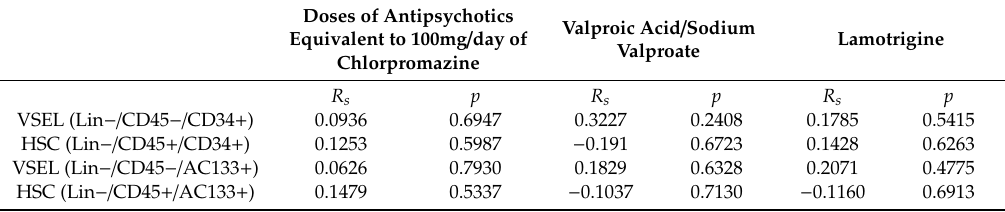
Table 3. Correlation between drug dose and stem cell